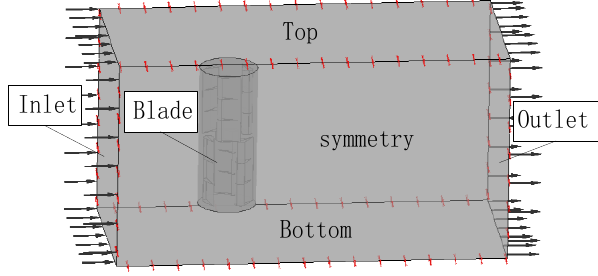
Figure 12. Boundary condition setting.